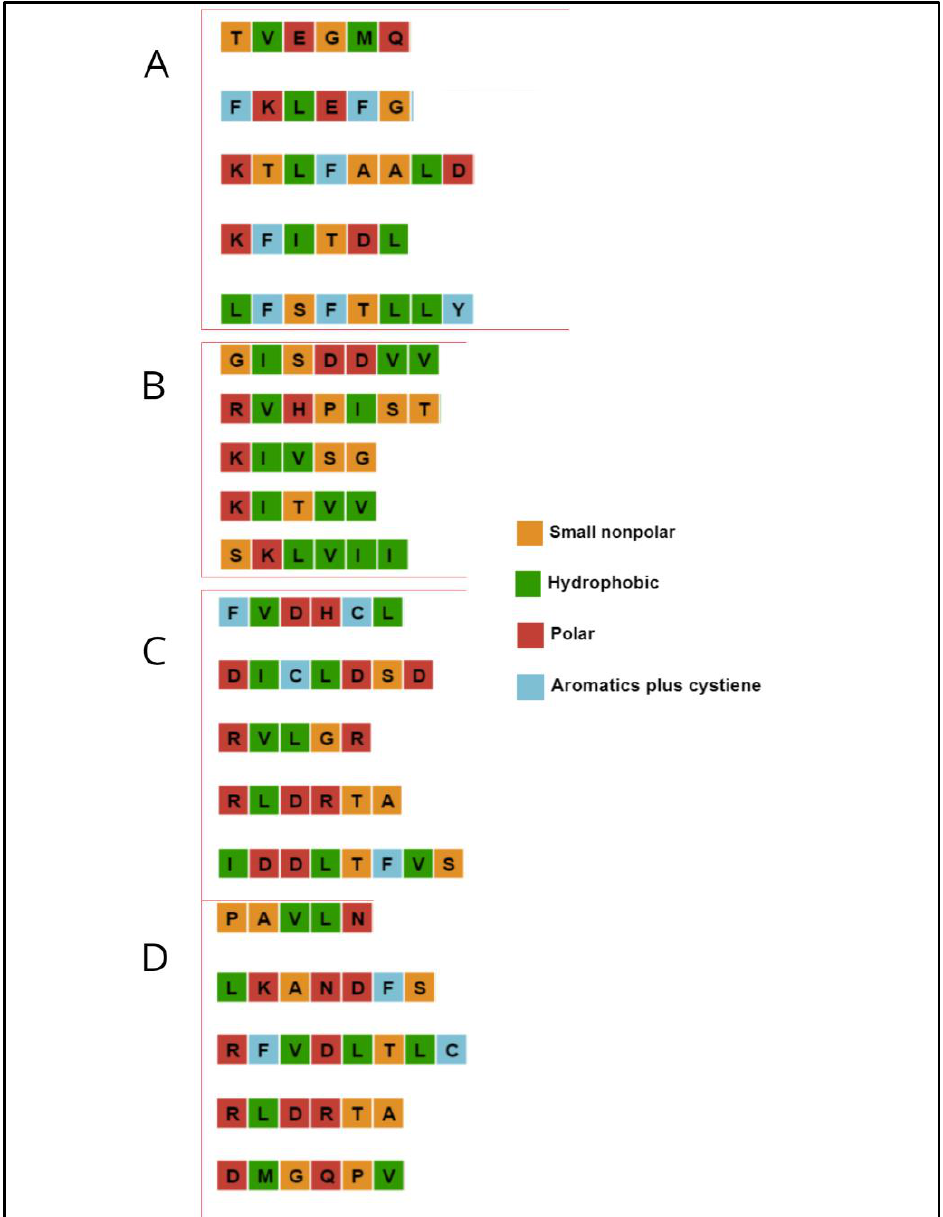
Figure 2. Graphic representation of the amino acid sequence of the ligands extracted from ( A ) the Mal 12 alpha glucosidase, ( B ) the A chain of the lactate dehydrogenase LDH, ( C ) Eco RI endonuclease and ( D ) THG lipase. The color code indicates the nature of the amino acid.